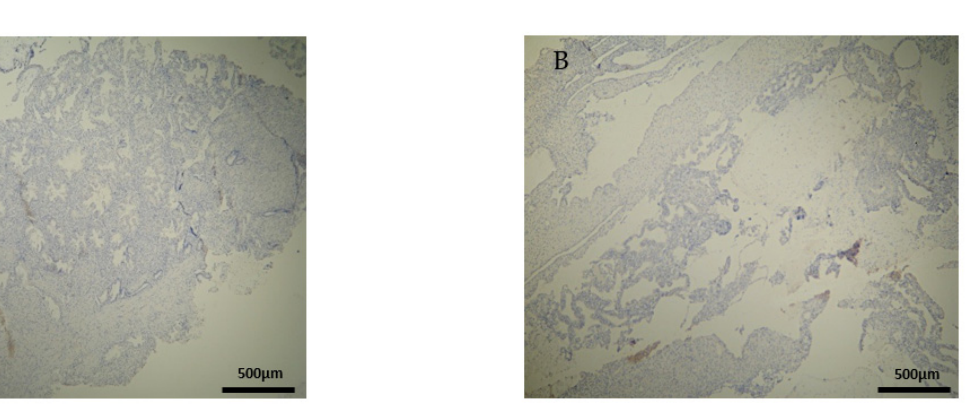
Figure 8. Evaluation of CD20 antigen positive expression. Control group (CG): ( Α ) Negative CD20 expression in the DP (4 × 4 magnification). ( Β ) Negative CD20 expression in the DB (4 × 4 magnification).